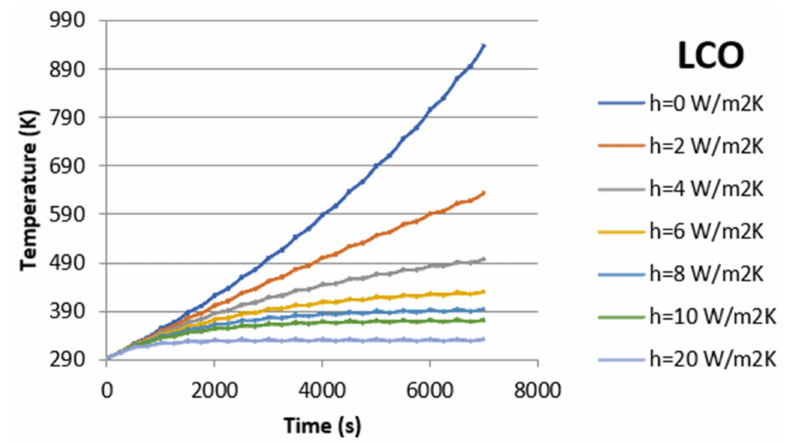
Figure 4. Temperature profile for an LCO cell in the absence of exothermic reactions.